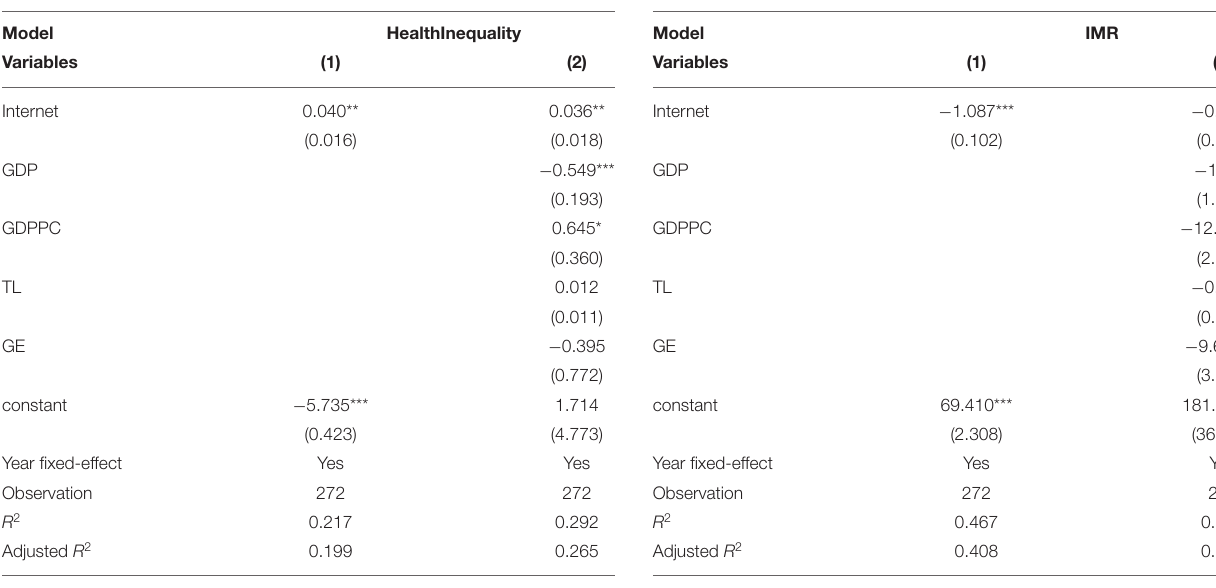
TABLE 3 | The impact of Internet access on health inequality (1993–2019). TABLE 4 | The impact of Internet access on the IMR